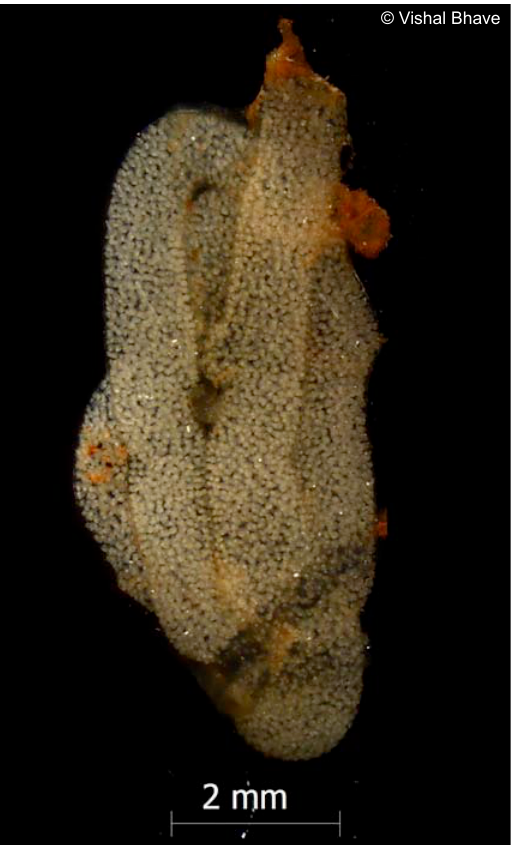
white and randomly marked with brown wavy lines. The rhinophores are creamy white; a subapical band of brownish-orange is present on rhinophore and is 1/4 th of rhinophore height. In some specimens, the base of the rhinophores shows an aggregation of brown wavy lines. Rhinophore tips are pale followed by pale brownish band which is one-fourth in size than that of the rhinophore. Gills are whitish and in some specimens with brownish pigmentation at the base. Oral veil is triangular with oral tentacles short with rounded corners.